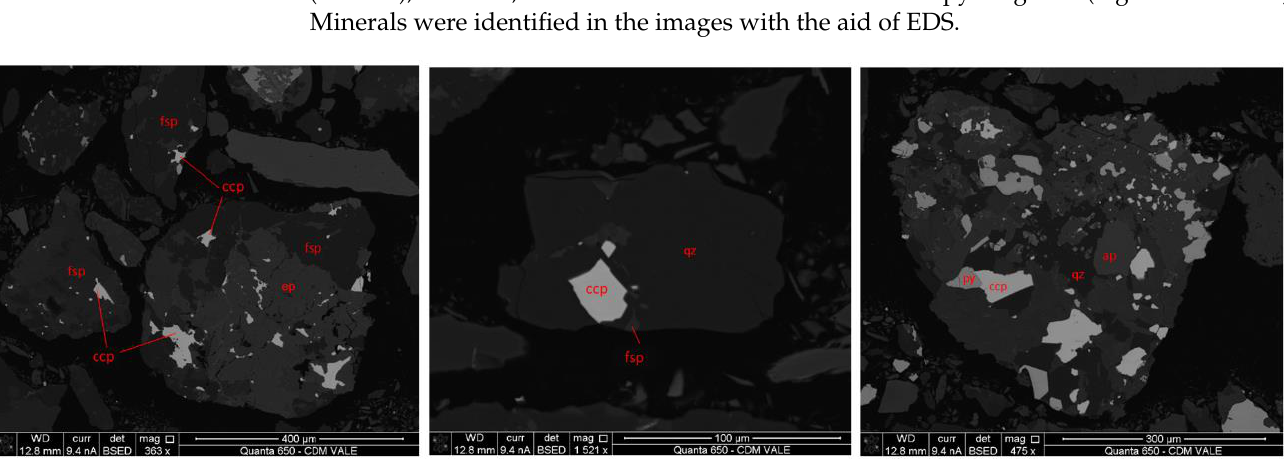
Figure 16. Backscattered electron images of the rougher tailings of sample 5Y-4m-25 × 12.5, showing chalcopyrite (ccp) grains locked in silicates particles (feldspar, fsp; epidote, ep; quartz, qz, apatite, ap). Complete list of acronyms and chemical formulas in Table S1.